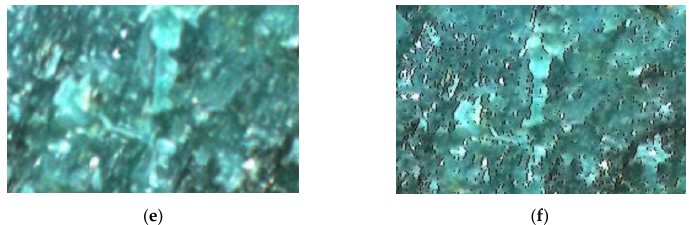
Figure 5. Samples of texture extraction for rock mineral images. ( a ) Cinnabar; ( b ) texture extraction of cinnabar; ( c ) calcite; ( d ) texture extraction of calcite; ( e ) malachite; ( f ) texture extraction of malachite.